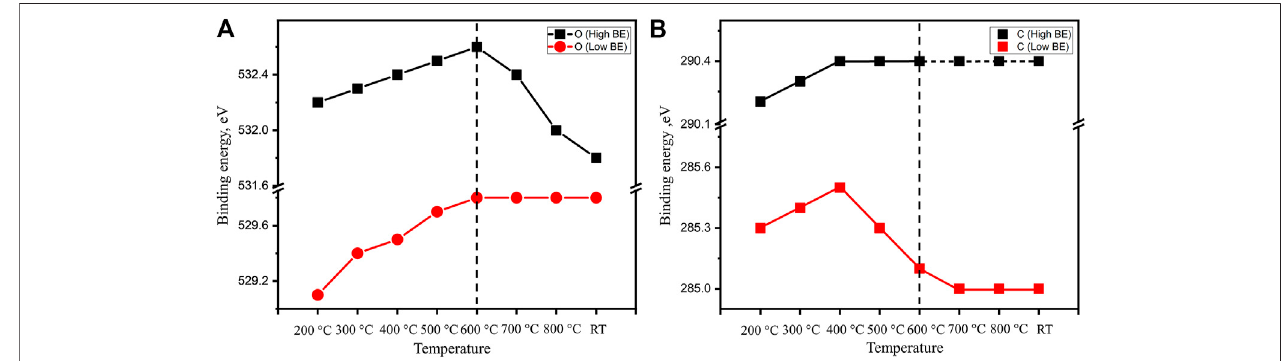
FIGURE 5 | The binding energy evolution of main features in (A) O 1s and (B) C 1s of an as-prepared fresh La 500, 600, 700, and 800 ° C and after following cooling to room temperature.